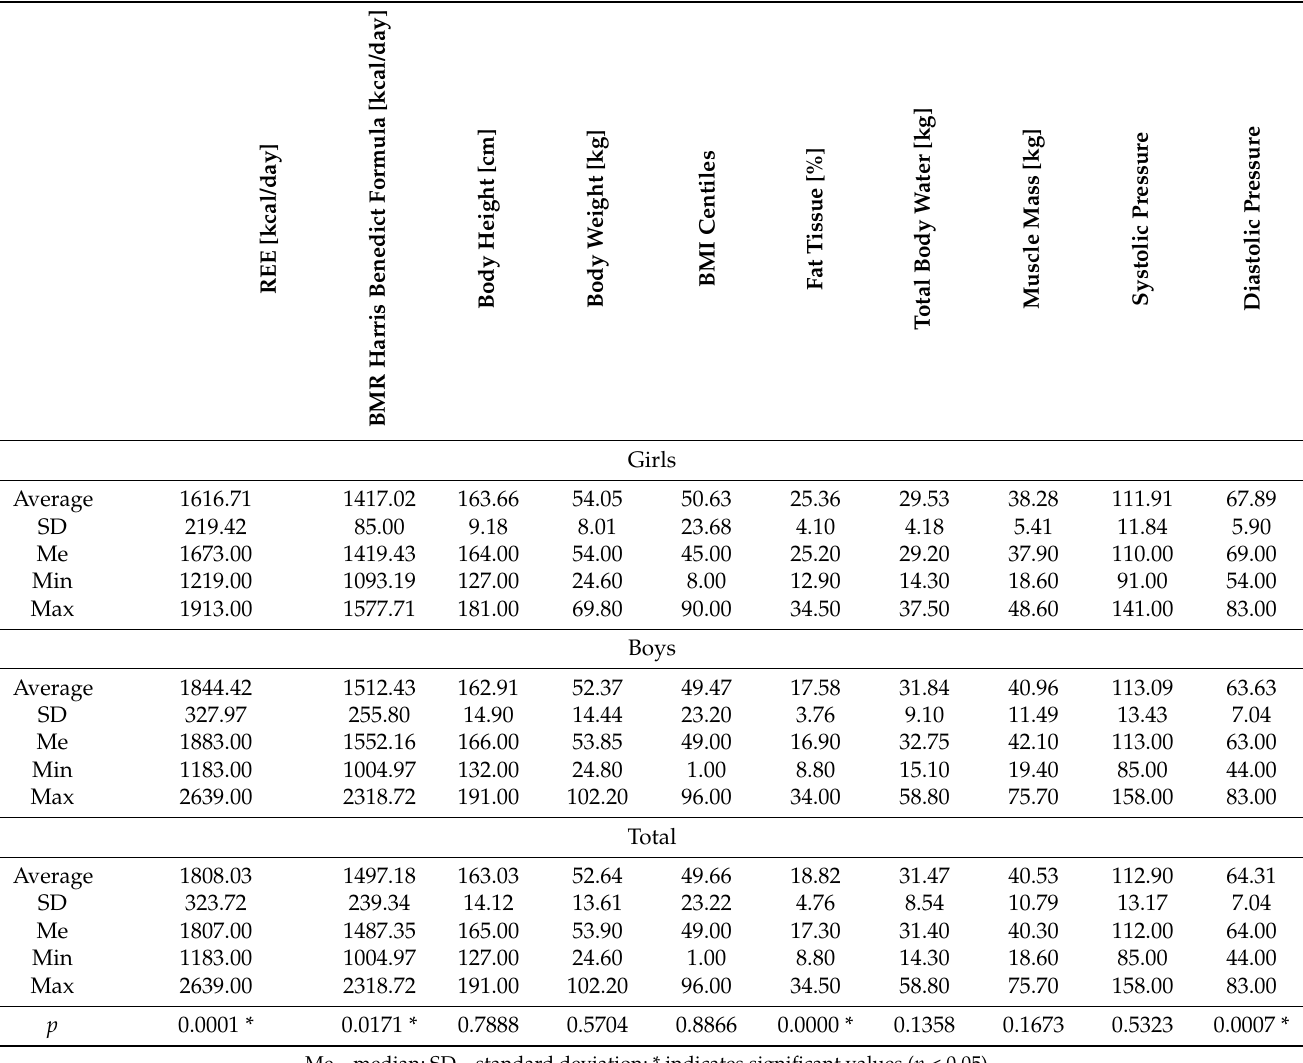
Table 1. Values of individual parameters in the study